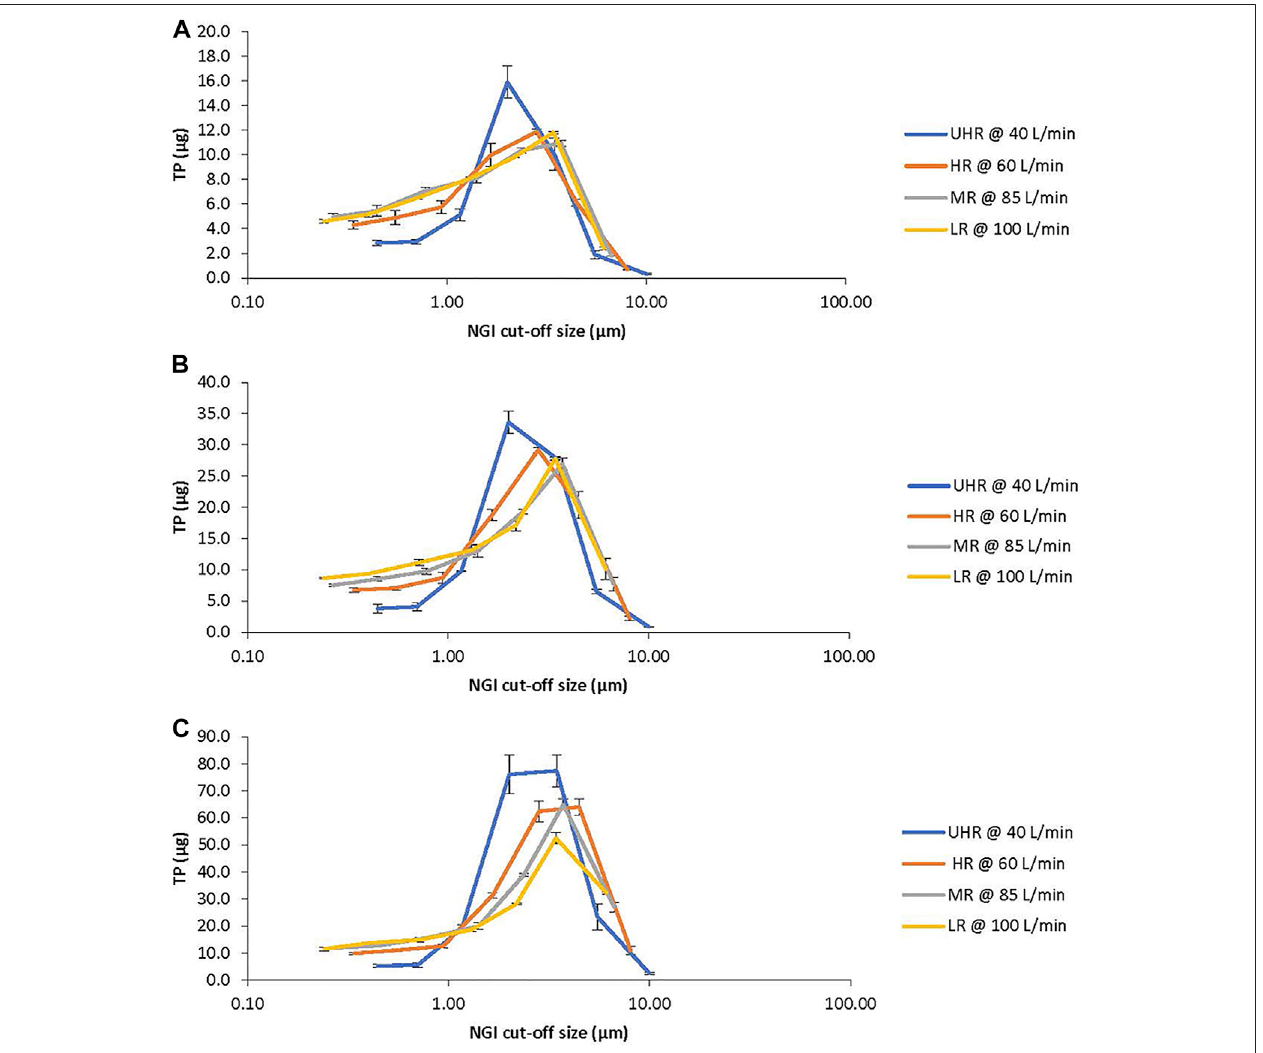
FIGURE 2 | TP Aerosol Particle Size Distribution Pro fi les from the Next Generation Impactor (NGI). The pro fi les show the recovery of TP (mean ± SD) from each stage of the NGI with respect to its stage cut-off diameter for the ultra-high resistance (UHR, blue), high resistance (HR, orange), medium resistance (MR, gray) and low resistance (LR, yellow) devices. (A) : 8 mg TPIP capsules. (B) : 16 mg TPIP capsules. (C) : 32 mg TPIP capsules.